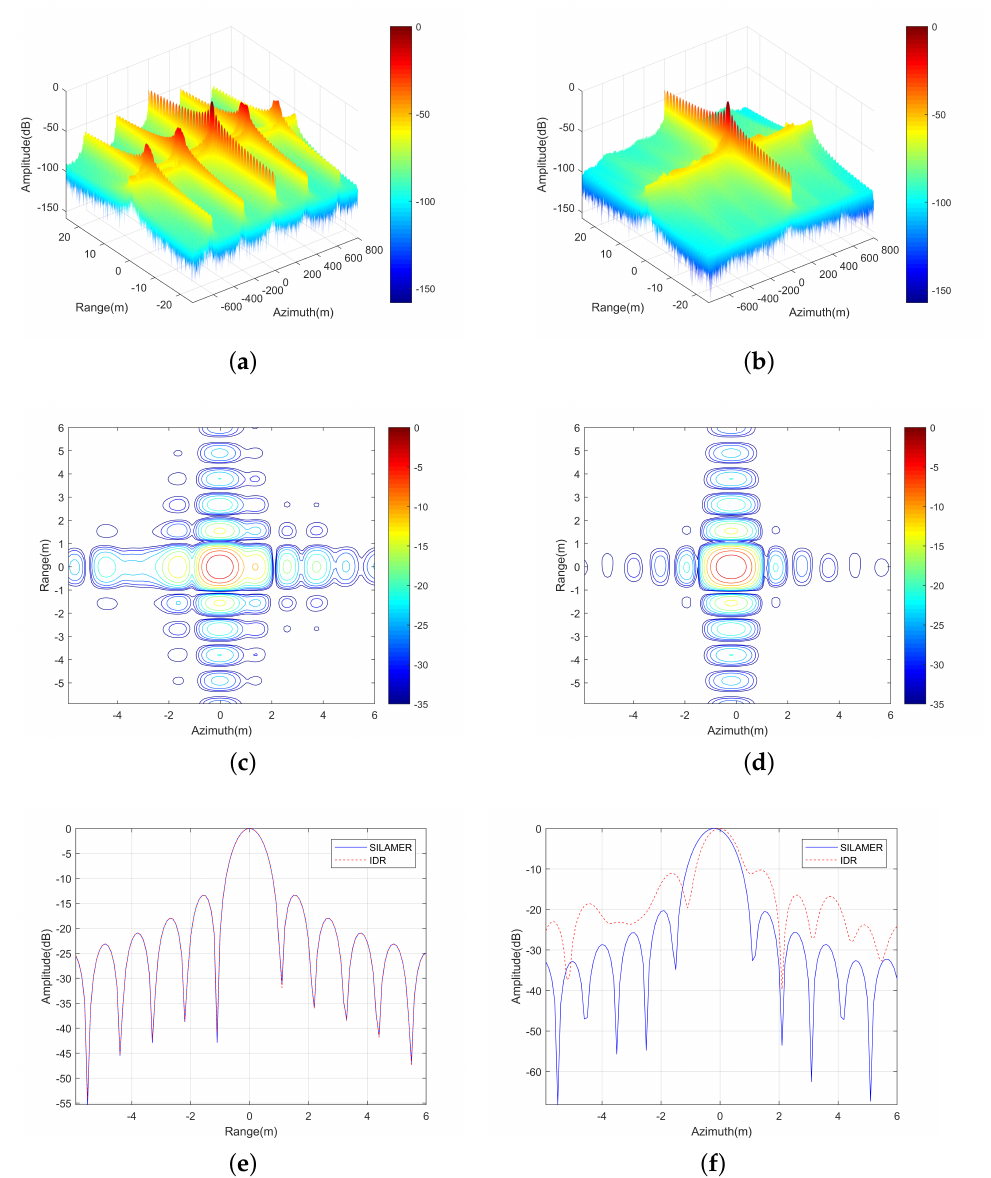
Figure 8. Imaging results of the point target with amplitude, phase, and baseline errors (by dB scale). ( a ) Reconstruction result by IDR; ( b ) reconstruction result by SILAMER; ( c ) contour plot of the target by IDR; ( d ) contour plot of the target by SILAMER; ( e ) 12 m range profile of the comparison of IDR and SILAMER; ( f ) 12 m azimuth profile of the comparison of IDR and SILAMER. In Table 3, image entropy, azimuth resolution, azimuth peak sidelobe ratio (PSLR), azimuth integrated sidelobe ratio (ISLR), and azimuth ambiguity-to-signal ratio (AASR) of the target are listed. It can be seen that the image entropy and AASR of SILAMER are lower than those of IDR. This shows that the image quality of SILAMER is better. The